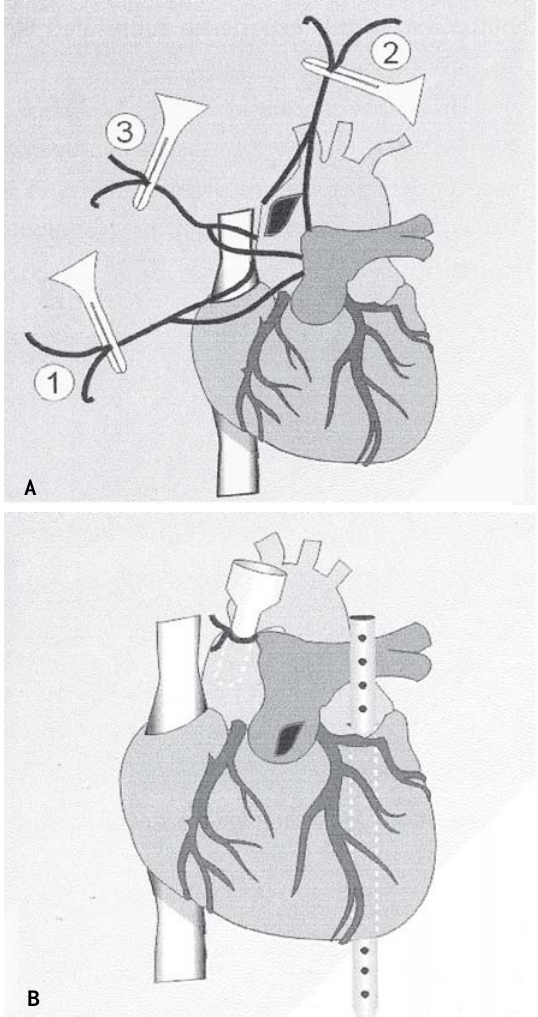
Fig. 3 - Variação percentual da Pressão Sistólica, +dP/dt -dP/dt max